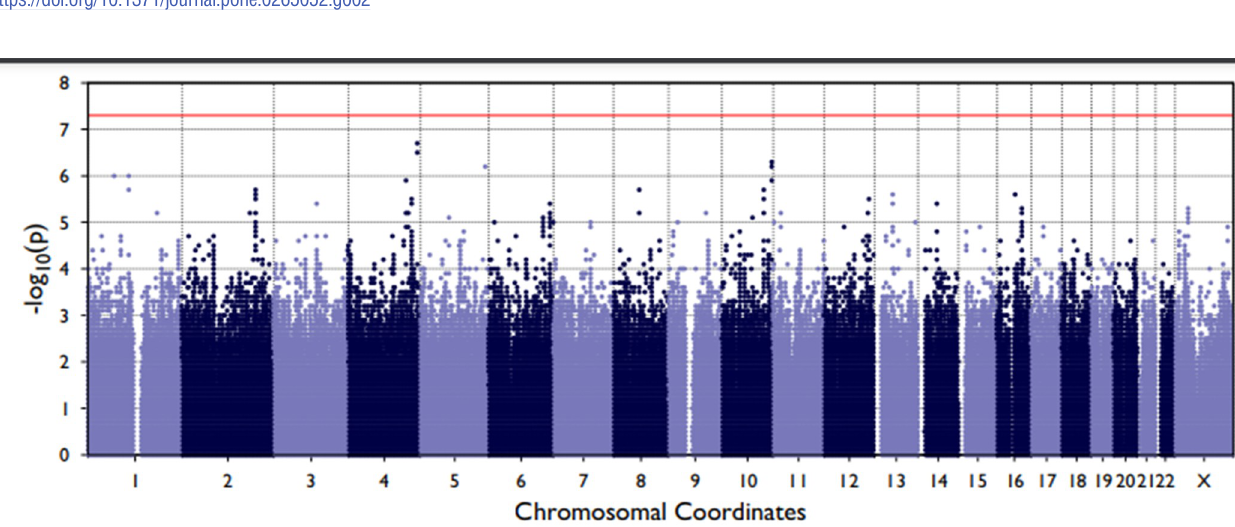
PLOS ONE | https://doi.org/10.1371/journal.pone.0265052 March 11, 2022 5 /